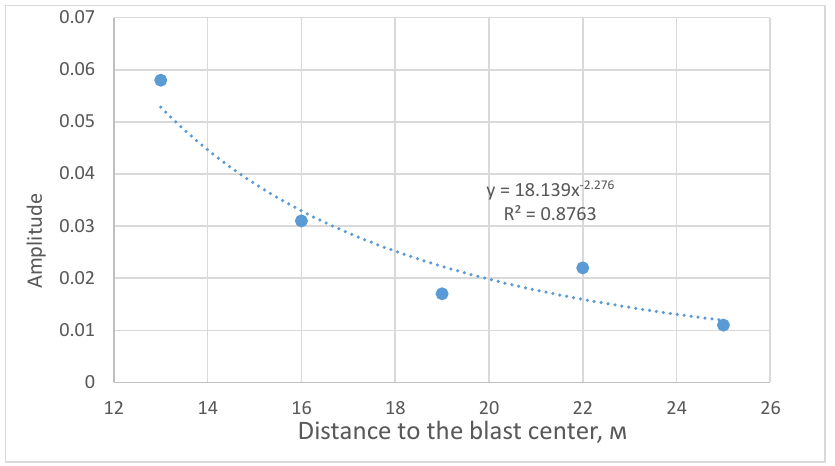
Figure 6. Amplitude dependence on the distance.